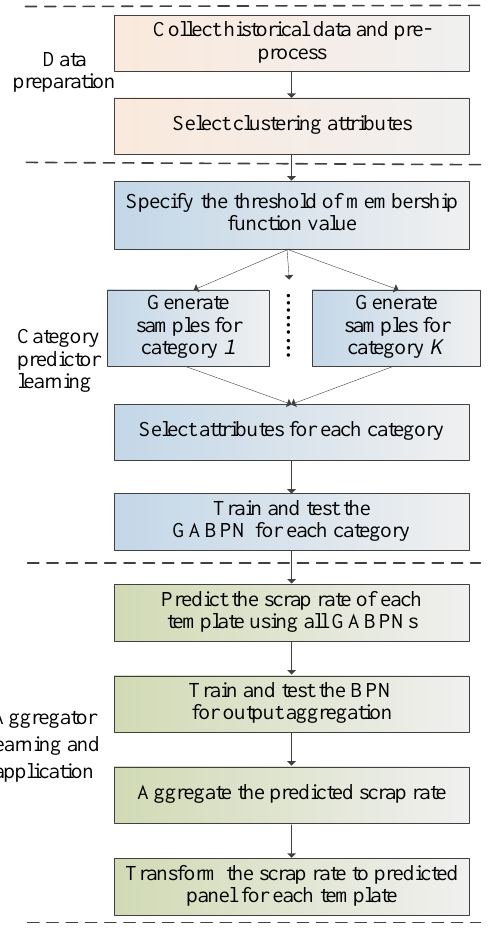
Figure 2. Procedure of the proposed FCM–GABPN.